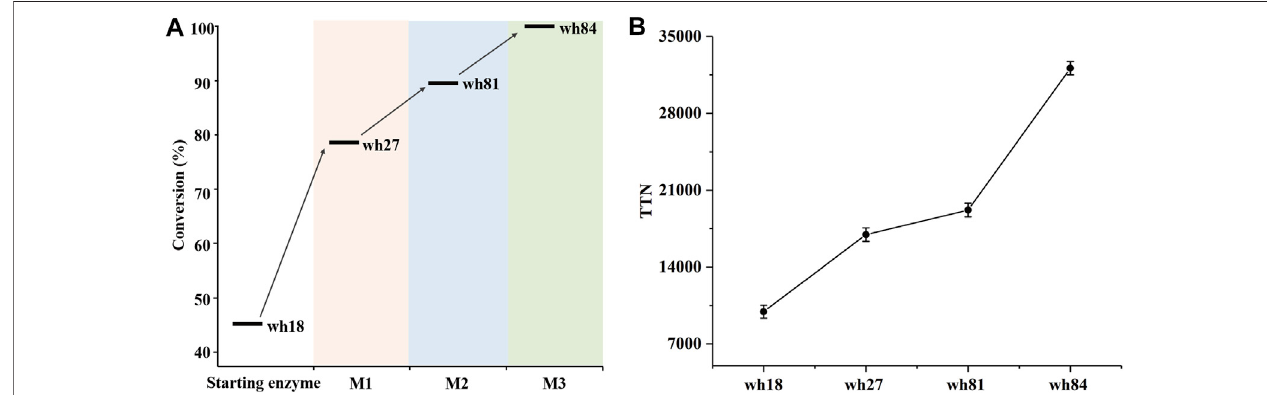
FIGURE 3 | Conversion (A) and TTN (B) analysis of the key variants using 40 mM substrate 1a. M1 ∼ M3 depicted the three rounds of mutagenesis.